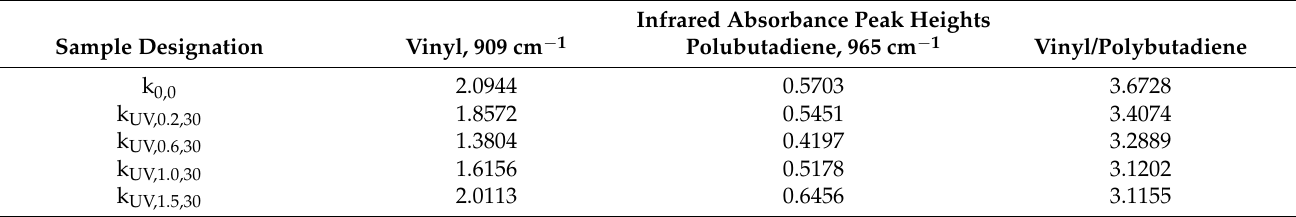
Table 4. Baseline subtracted characteristic peak height ratios of vinyl to polybutadiene for the control sample and some selected for the 30 s UV-irradiated samples.